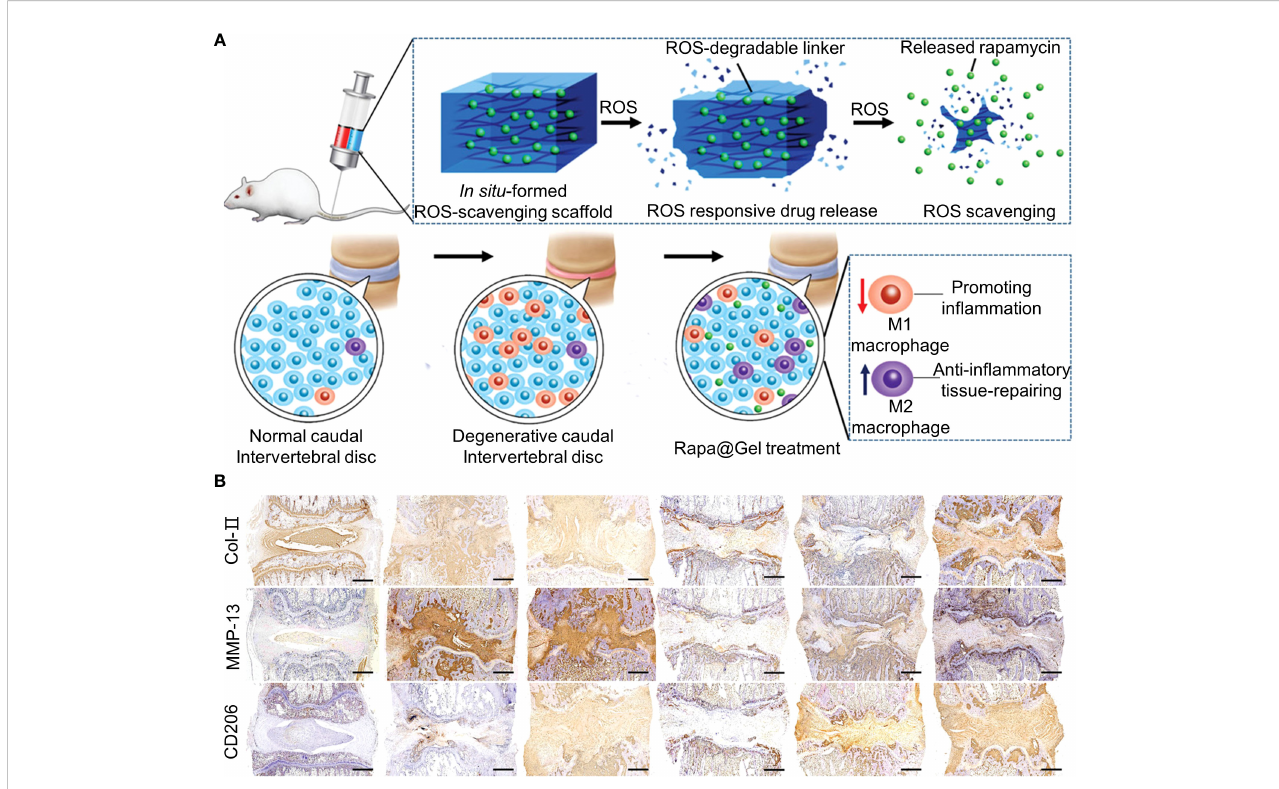
FIGURE 6 (A) Schematic representation of Rapa-loaded ROS-responsive hydrogels. (B) Immunohistochemical staining for collagen type II (COL2), matrix metalloproteinase 13 (MMP13), and CD206 at week 12. Immunohistochemical staining showed that COL2 expression was upregulated, MMP13 expression was downregulated, and CD206 expression was upregulated in the rapamycin-treated group compared with the degenerative control group. Reproduced with permission from